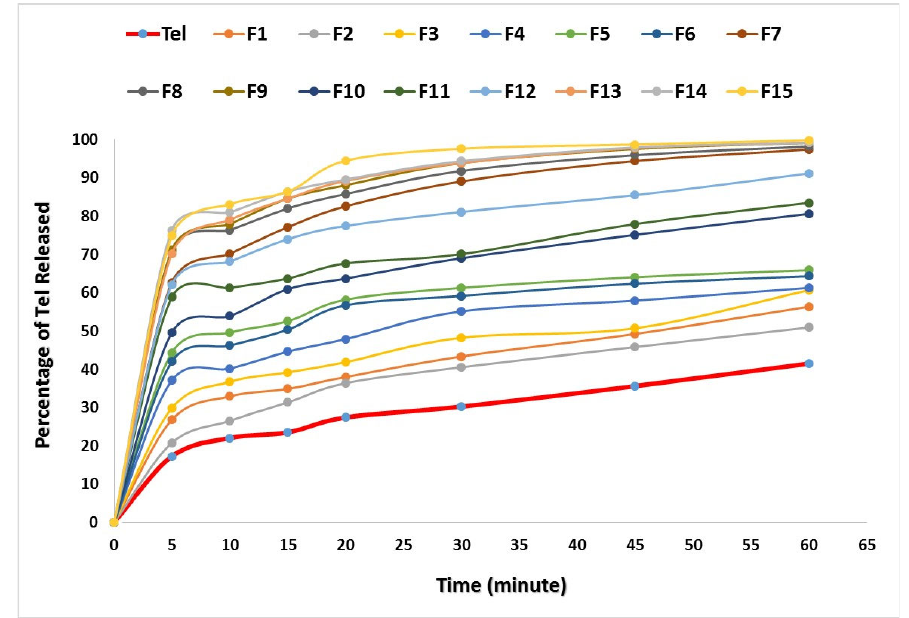
Figure 4. Dissolution profile of plain and Tel ‐ SSDs.